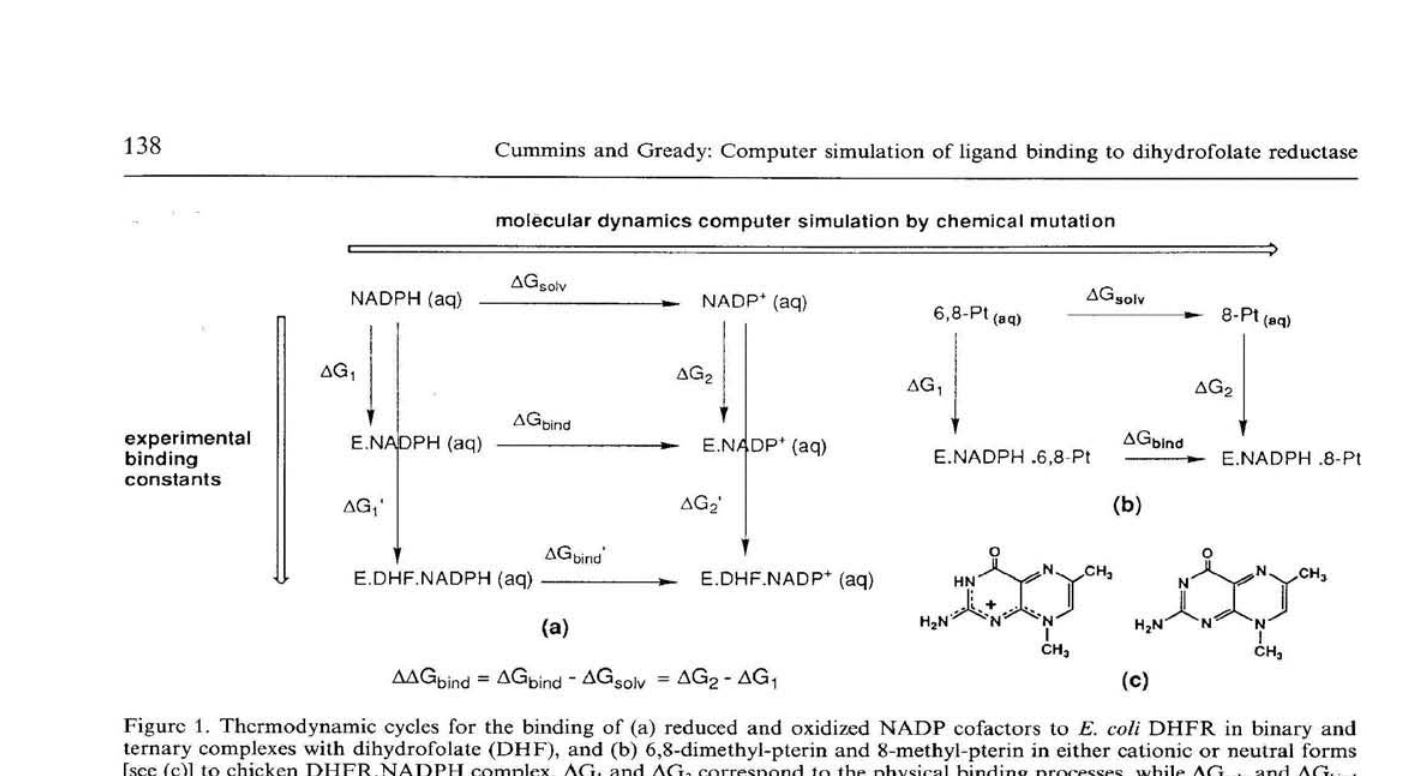
Figure 1. Thermodynamic cycles for the binding of (a) reduced and oxidized NADP cofactors to E. coli DHFR in binary and ternary complexes with dihydrofolate (DHF), and (b) 6,8-dimethyl-pterin and 8-methyl-pterin in either cationic or neutral forms [see (c)] to chicken DHFR.NADPH complex. AG, and AG, correspond to the physical binding processes, while AG solv and AG bind correspond to non-physical processes in the FEP/MD simulations during which one ligand is mutated into the other in either aqueous solution or when bound to the enzyme. The relative free energy of binding of the two ligands is AAG bind .